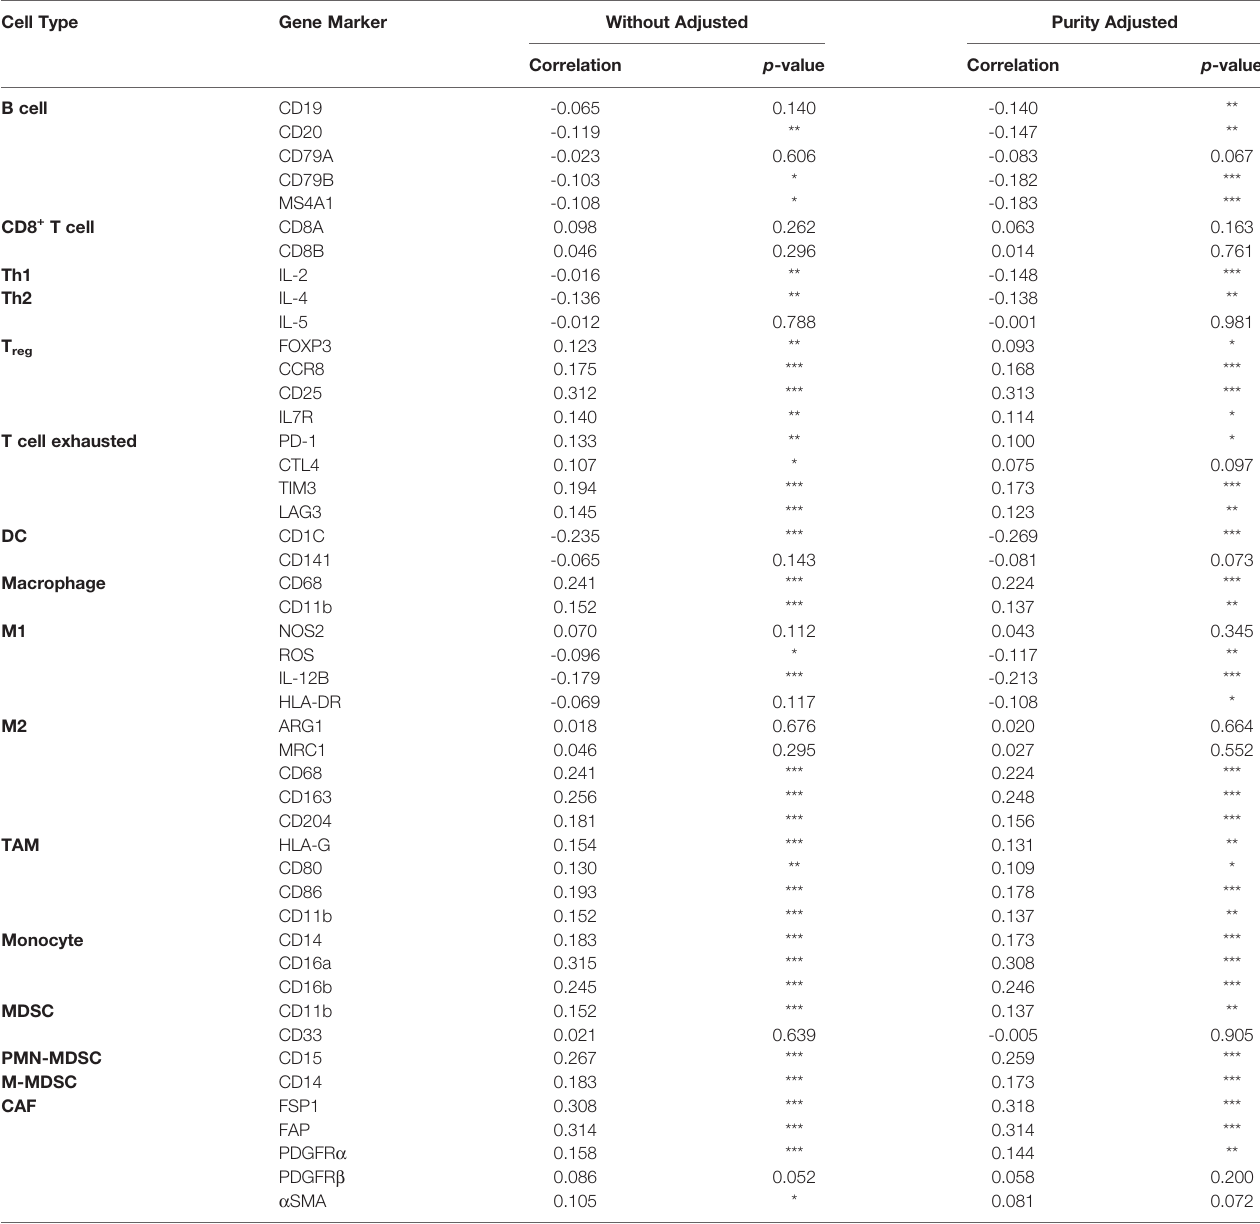
TABLE 2 | Correlations between ERO1L and gene markers of in fi ltrating immune cells. Cell Type Gene